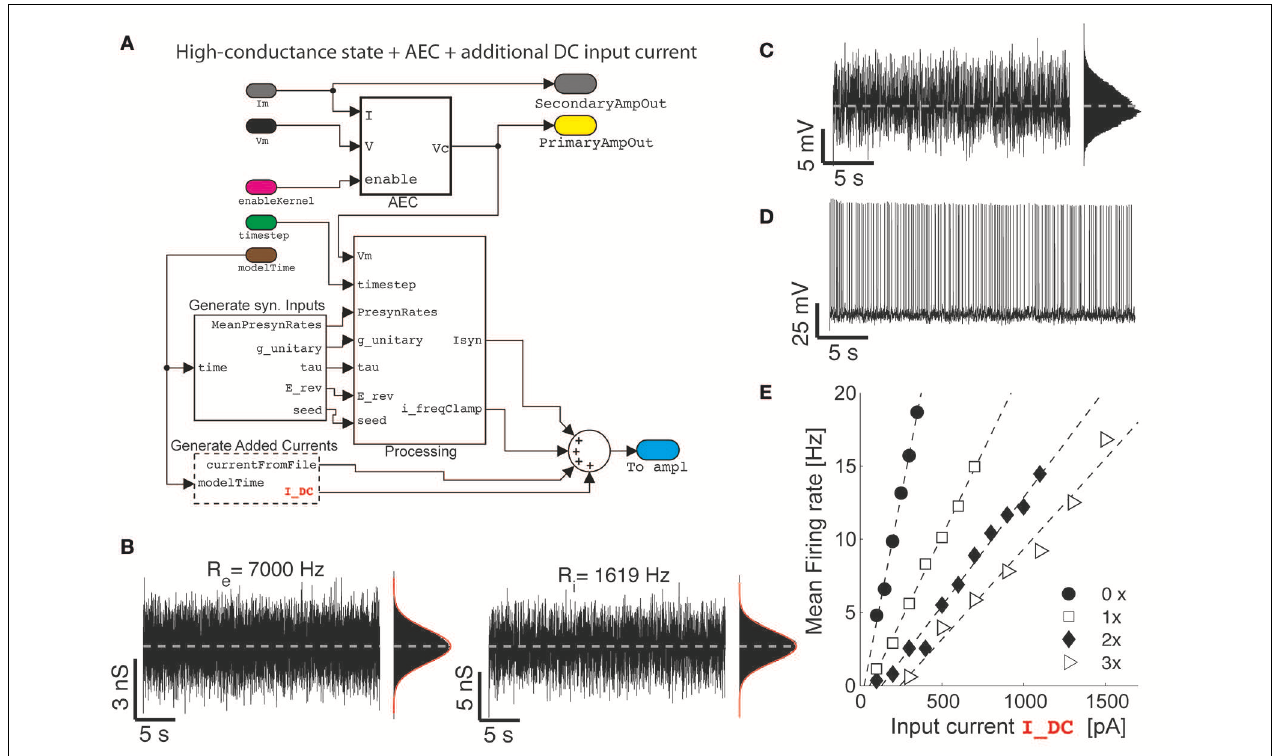
2002; Destexhe et al., 2003 ), the impact of such an artificial in vivo -like synaptic background induce a steady membrane depolarization and random fluctuations in the potential of the neuron (C) , irregular firing (D) , and increasingly bends the single-cell frequency-current curve reducing its slope ( E ) (i.e., 0 × : R e = R i = 0 Hz ; 1 × : R e = 7000 Hz; 2 × : R e = 14 , 000 Hz; 3 × : R e = 21 , 000 Hz; with R i calculated to “balance” on the average the injected current—i.e., by solving 0 = (cid:10) G e ( t ) (cid:11)(cid:0) E e − V b (cid:1) + (cid:10) G i ( t ) (cid:11)(cid:0) E i − V b (cid:1) with V b set 1–2mV below the voltage firing